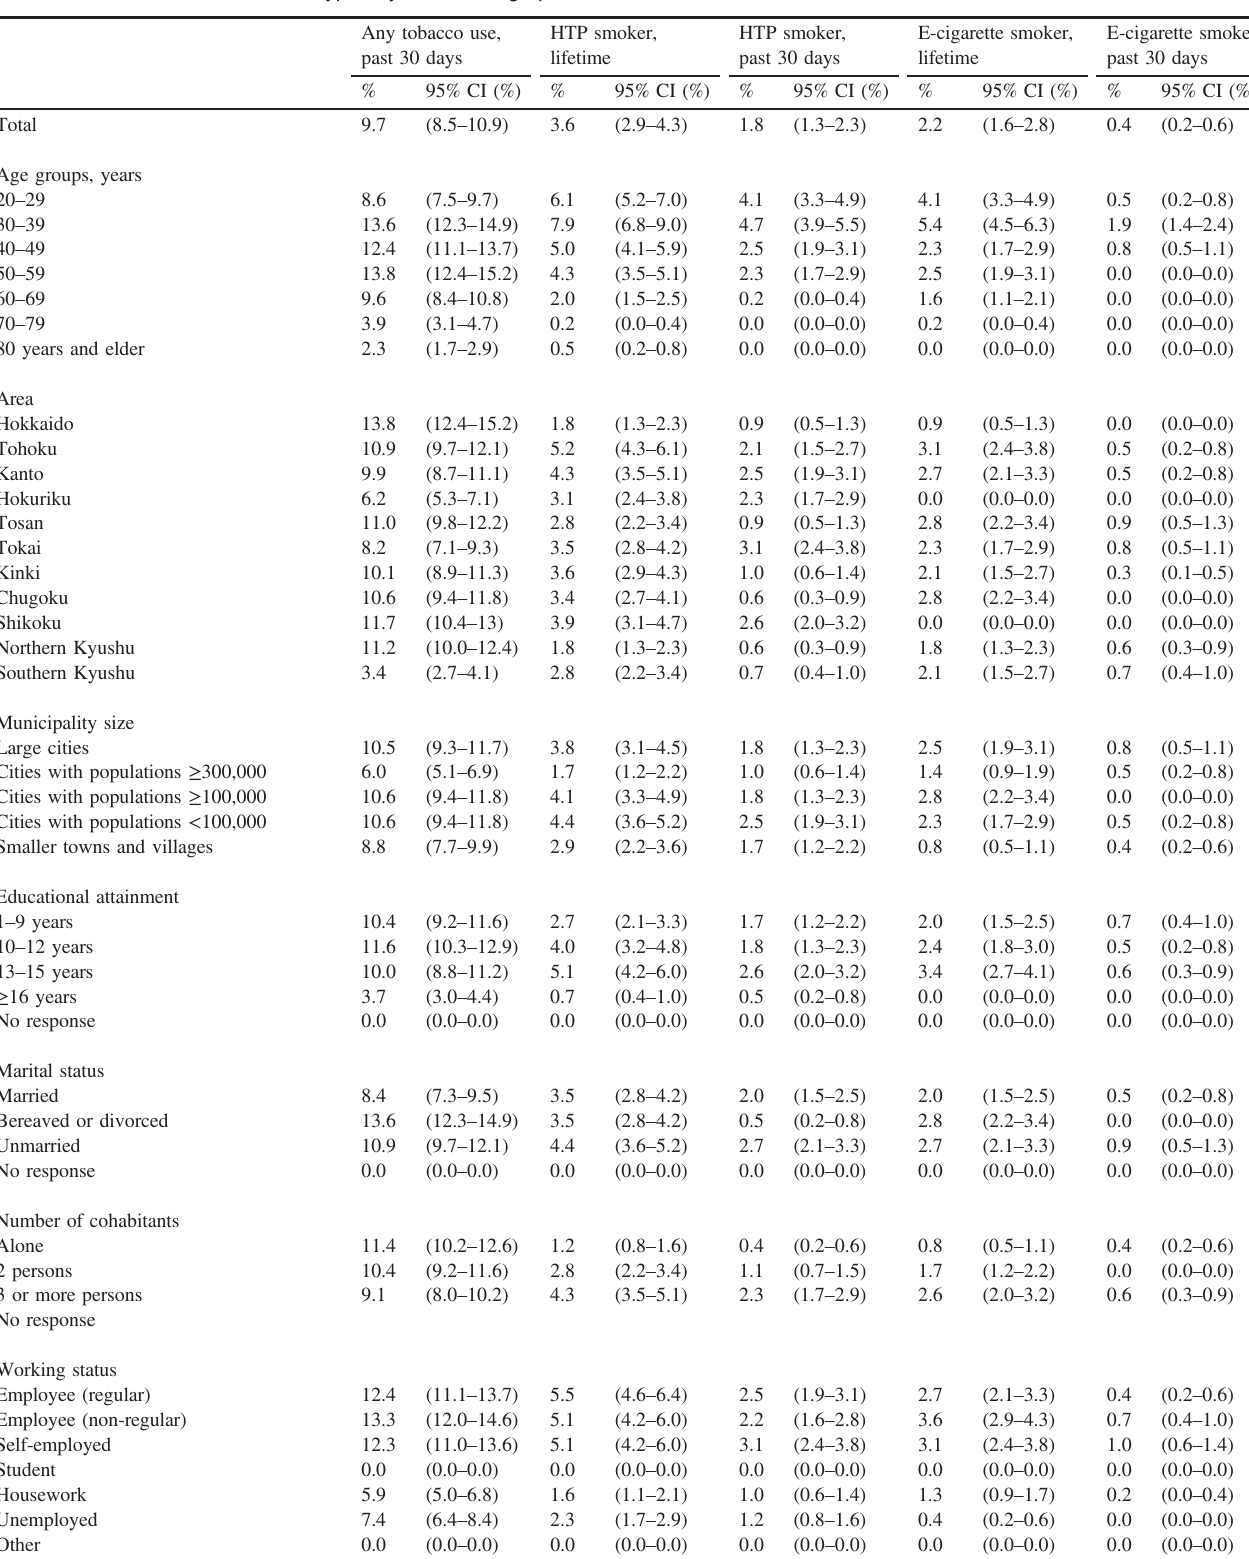
Table 4. Female tobacco smoker types by sociodemographic